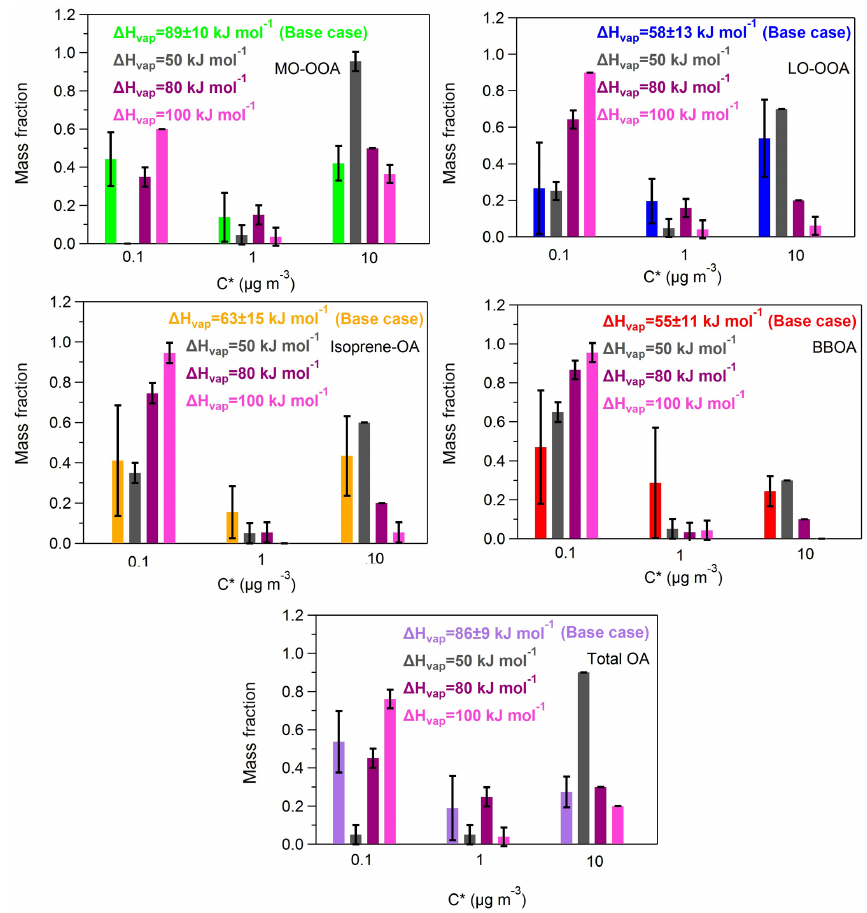
Figure A2. Predicted volatility distributions of the OA PMF factors and total OA for fixed vaporization enthalpy. The error bars are estimated using the approach of Karnezi et al. (2014). The grey bars represent the results of a constant (cid:49)H vap of 50kJmol − 1 , the magenta bars correspond to the solution of a constant (cid:49)H vap of 80kJmol − 1 and the pink bars are the results for the case of a constant (cid:49)H vap of 100kJmol − 1 . The green, blue, orange, red and purple bars stand for the base case solutions of MO-OOA, LO-OOA, isoprene-OA, BBOA and total